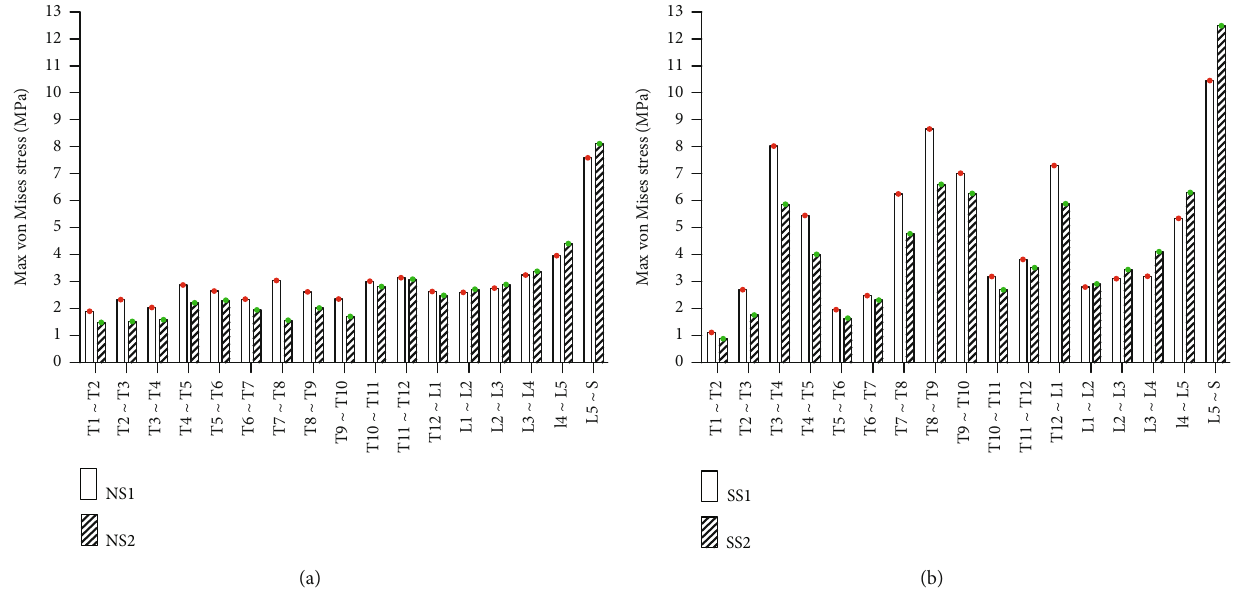
Figure 7: Stress distribution of discs in four spinal models with right curvature: (a) stress distribution of normal spinal intervertebral discs; (b) stress distribution of scoliotic spinal intervertebral discs. NS1, NS2, SS1, and SS2 need to be de fi ned here.